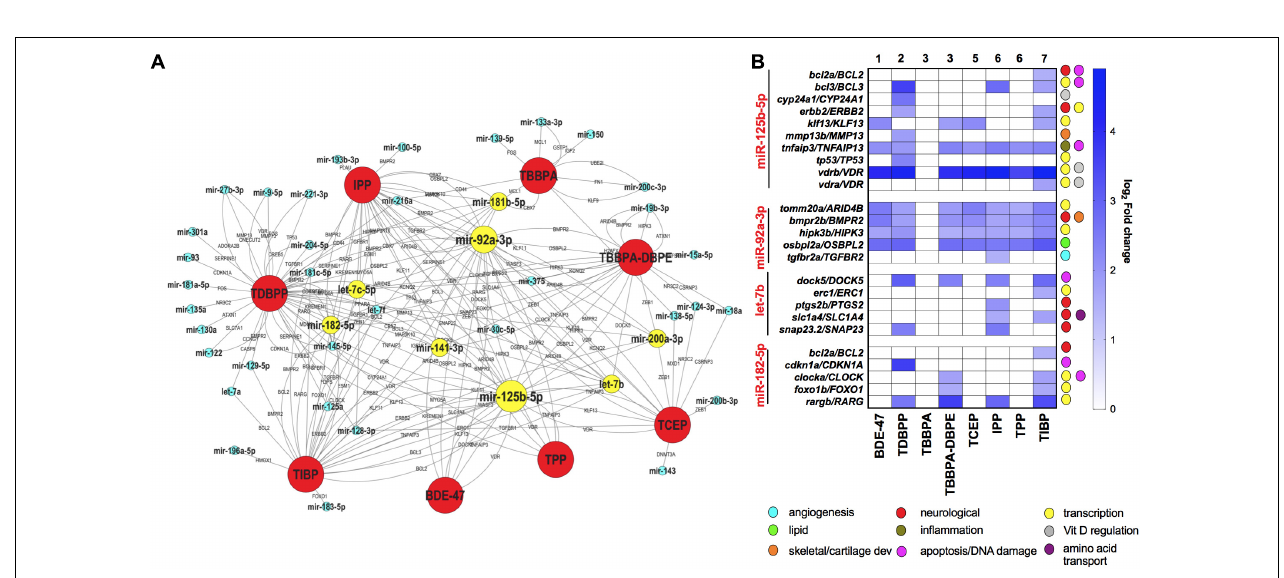
FIGURE 5 | mRNA-miR interactions across FRCs based on experimentally validated predictions. (A) FRC-mRNA-miR co-regulatory network based on TFmiR gene-miR interactions. Only mRNA-miR pairs with reverse expression directions were considered for the network. • FRCs, • miRs, • miRs that were differentially expressed across 4 or more FRCs, with larger nodes denoting higher number of FRCs. mRNAs are represented within the connected lines. (B) Selected miRs that were decreased across multiple FRCs, with fold changes and major functions (based on GO analysis) of their anti-correlated mRNA targets in specific FRCs. Numbers represent FRC classes based on Figure 1 . TBPH and TCPP not represented since there were no miR disruptions.